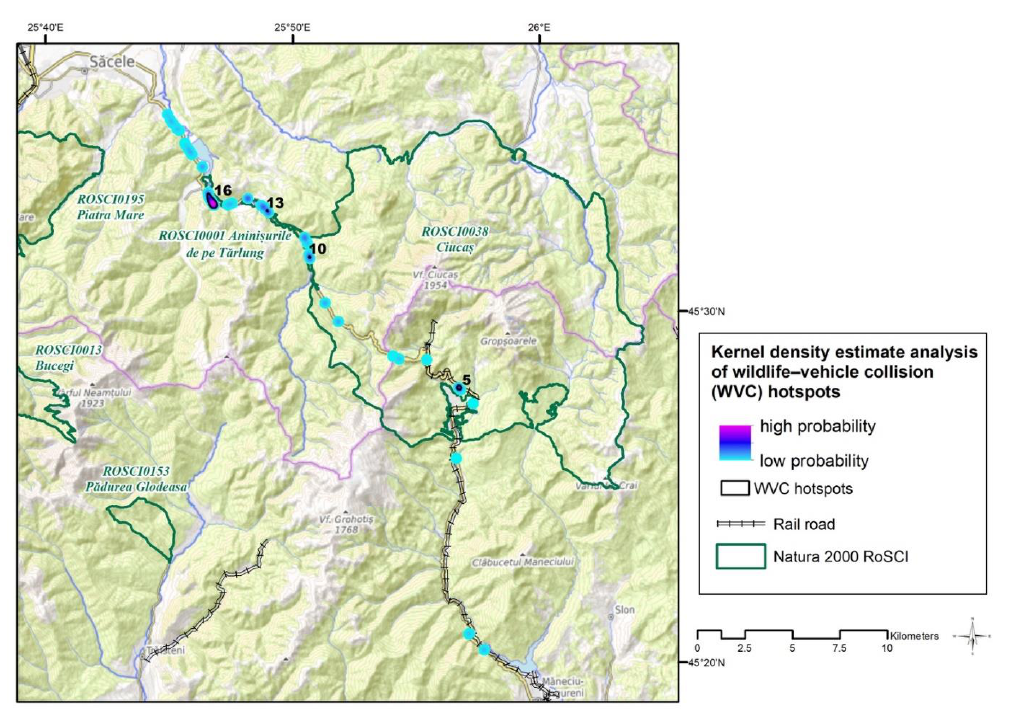
Figure 3. Model-based estimation of collision risk for Sacele–Maneciu (DN1A). High probability is represented in purple, and the WVC hotspot is dark